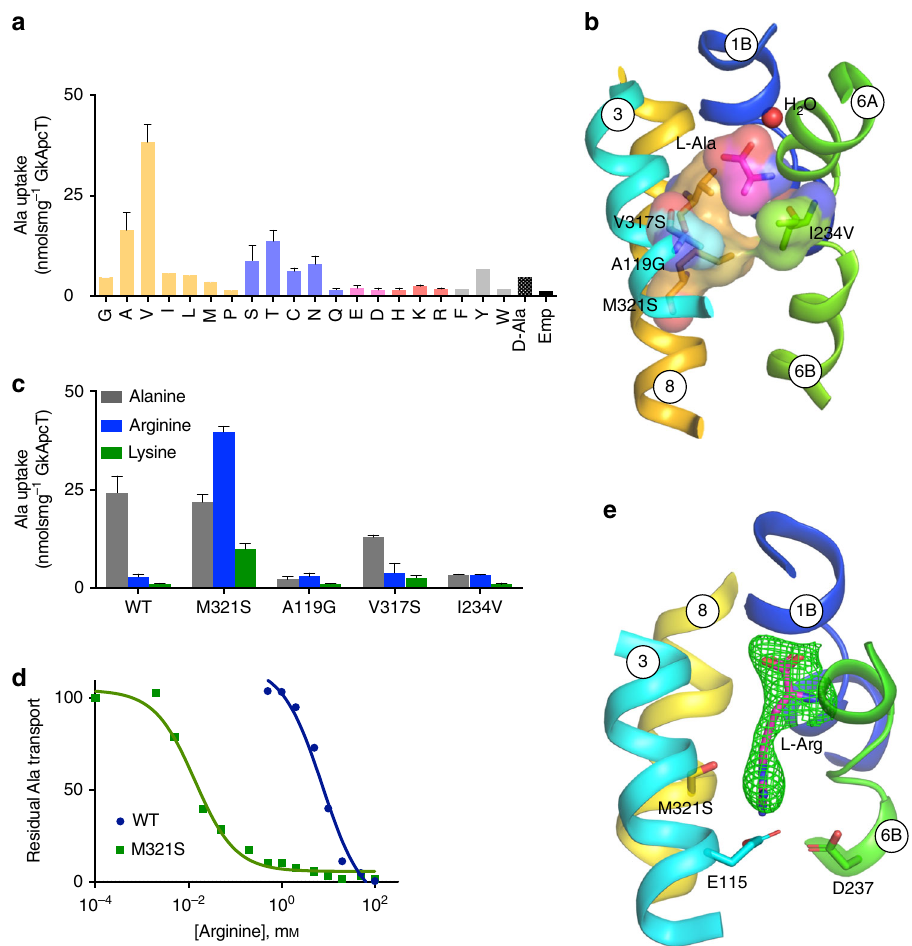
Fig. 4 Functional characterisation of the amino acid binding site. a Substrate speci fi city of GkApcT analysed using counter fl ow of the 20 canonical amino acids plus D -Ala and a water control (emp) using external 3 H L -Ala. n = 3 independent experiments, error bars s.d. b View showing the molecular volume of the side chains within the binding site of the WT GkApcT structure. Due to the size of Met321, there is no space to accommodate the extra side chain bulk of L -Arg. c Effect of mutating residues in the binding site to their counterparts in CAT-2A. Accumulation was measured using 3 H L -Ala uptake using counter fl ow accumulation with internal L -Ala, L -Arg or L -lys. n = 3 independent experiments, error bars s.d. d Crystal structure of the Met321Ser variant with bound Arginine (purple), shown in sticks. The mFo-DFc difference electron density map contoured at 3 σ , (green mesh). e Representative IC 50 curves determined for L -Arg binding to either the WT or M321S variant of GkApcT using an electrogenic uptake assay. IC 50 values were calculated from three independent